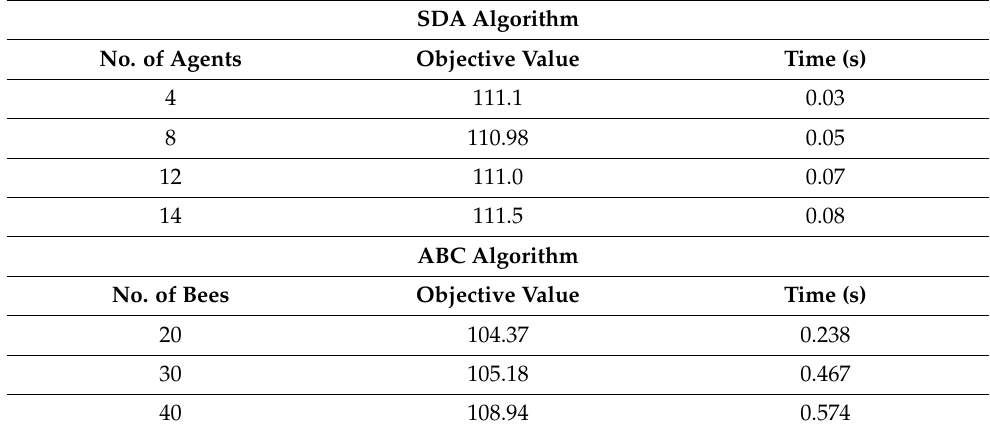
Table 1. Comparing performance of the proposed algorithm and Artificial Bee Colony (ABC)